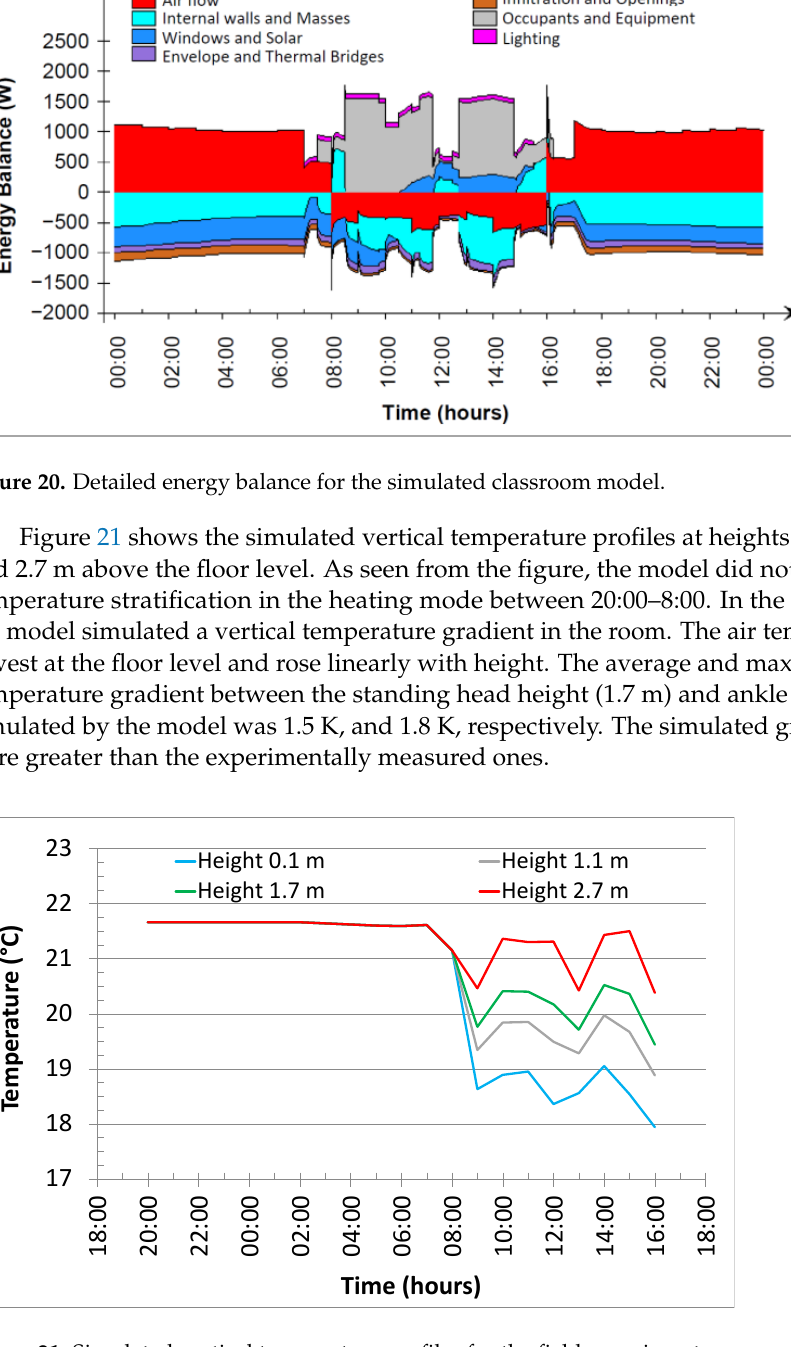
Figure 21. Simulated vertical temperature profiles for the field experiment. Figure 22 presents the simulated CO 2 concentration in the classroom during the field experiment. As noted earlier in Section 4.2, the IDA-ICE model could only apply a simple CO 2 balance in the zone and could not calculate vertical stratification or horizontal gradient of CO 2 concentration in the zone. The figure shows that in the heating mode between 20:00–8:00 when there were no CO 2 sources present in the classroom, the simulated CO 2 concentration in the classroom was equal to the outdoor concentration. In the normal